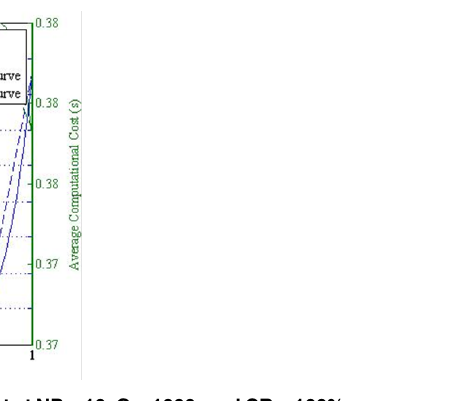
Fig 4. Estimation of optimum differential weight at NP = 10, G = 1000, and CR =